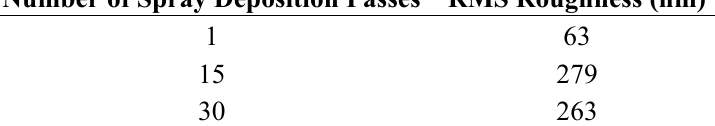
Table 2. Surface RMS roughness at different number of spray deposition passes for a field of view of 130 μ m × 130 μ m; carrier air pressure is 0.2 MPa, flow rate is 1 mL/min, and concentration is 1.8 mg/mL.